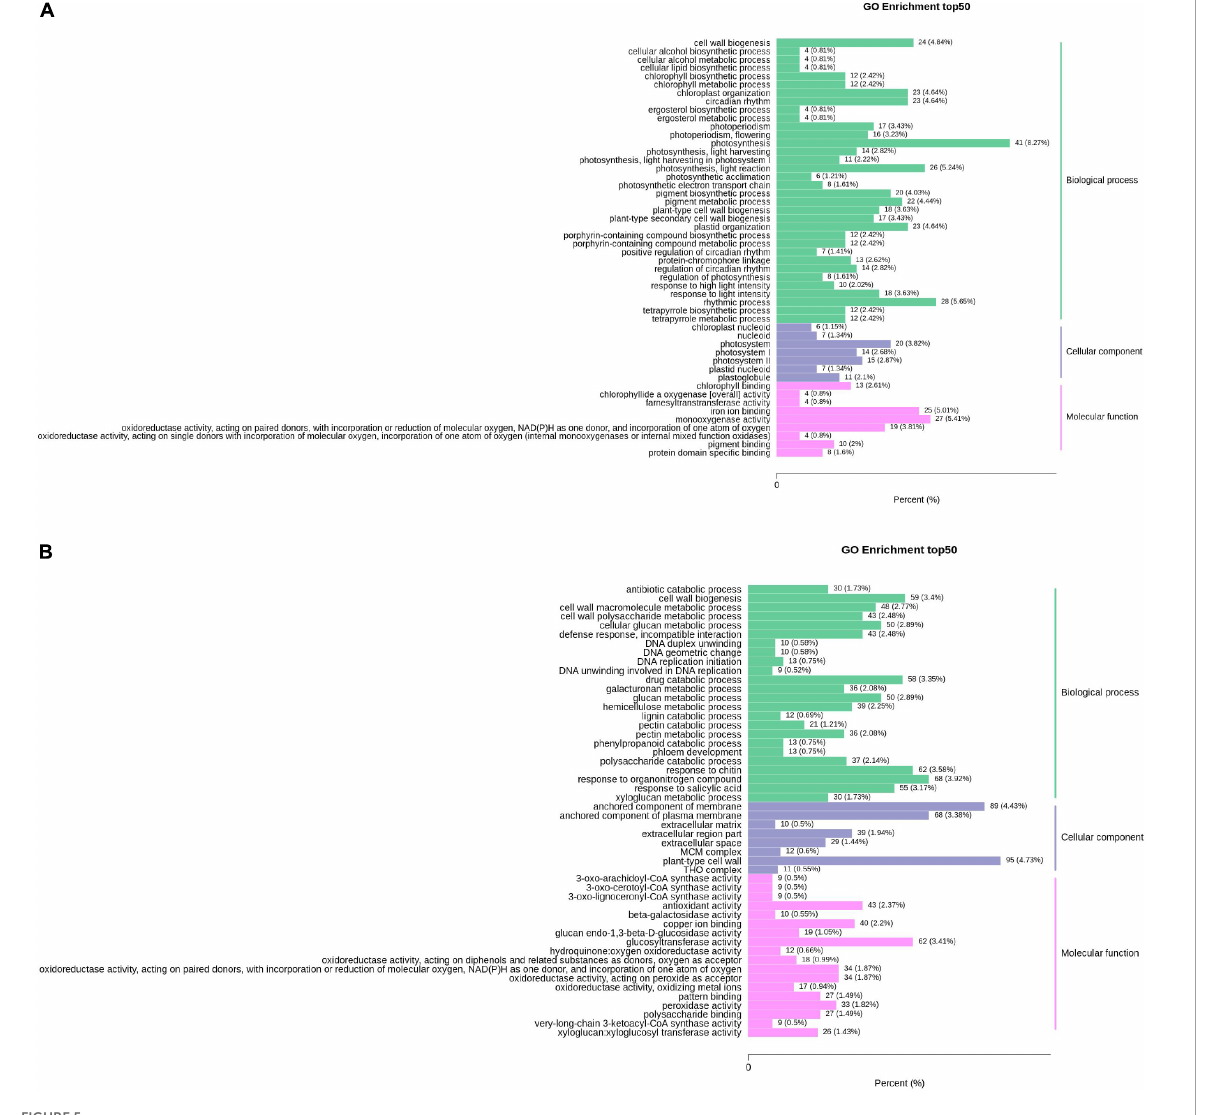
vs. HN65-DPC ( Figure 11B ) were downregulated at the transcriptional level. Except for the gene CYP71D10 ,